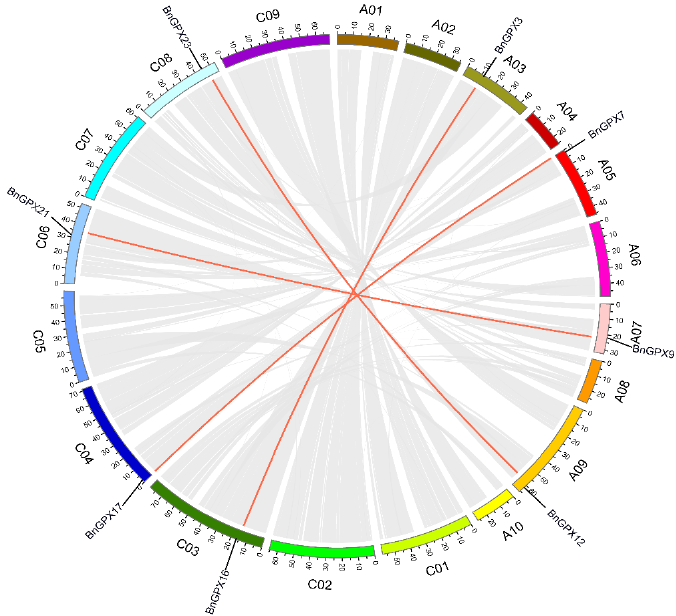
Figure 2. Circular drawings of the chromosomal distribution and inter-chromosomal organization of BnGPX genes. Gray lines in the background signify all the syntenic blocks in the rapeseed genome and the red lines indicate syntenic GPX gene pairs.